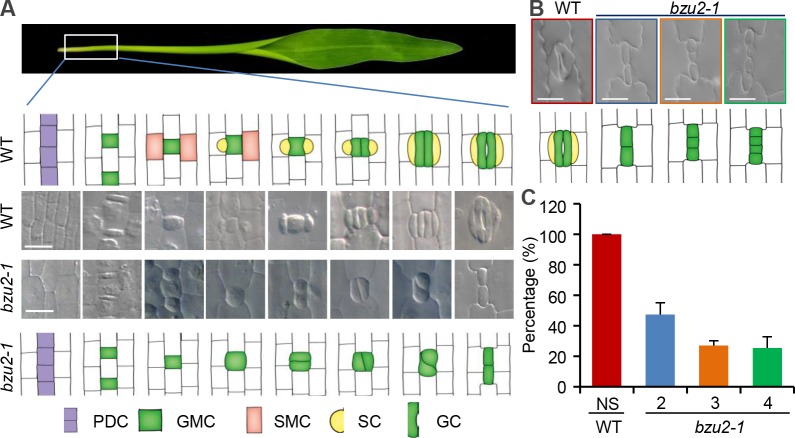
BZU2 is required for the formation of guard cells and fate determination of subsidiary mother cells.(A) Diagrams show the stomatal development file of the base of the second leaf, comparing wild-type and bzu2-1 mutants. In maize leaves, stomata are arranged linearly, being strongly zoned with the youngest at the base of the leaf (first panel). The cell proliferation zone of the files (purple region), where the stomata will form, is established first. Next, an asymmetric division of the protodermal cell establishes a GMC (green) and laterally induces SMC fate (orange). Subsequently, SMCs divide asymmetrically to form the SCs (yellow), prior to a final symmetric division of the GMCs to form the mature stomatal complex, comprising two GCs (green) and two SCs (yellow) (second and third panel). Compared to the wild-type, in bzu2-1 mutants, PDC can develop to GMCs at early stages of this process. However, SMCs do not undergo the asymmetric division to form the SCs, and the longitudinal symmetric division of GMCs is disturbed. Instead, they undergo transverse or diagonal longitudinal divisions that produce short columns of elongated cells lacking characteristic guard cell morphology (fourth and fifth panel). Scale bars, 25 μm. (B) Images of stomata illustrating the phenotypic range observed in bzu2-1 mutants in the first leaf. Wild-type plants have 4-celled stomatal complexes comprising two GCs and two SCs. bzu2-1 mutant plants never make SCs and, instead, produce two-celled defective stomata. These sometimes undergo one or two more divisions to form 3- and 4-celled defective stomata. Scale bars, 25 μm. (C) Percentage of stomatal complexes showing irregular divisions of the GMCs in bzu2-1 mutants. In the first leaves from 8-day-old wild-type and bzu2-1 mutants, three independent micrographs were examined, each value representing the mean (± SD), with error bars indicating SD, n = 6, **P<0.01, Student’s t test. In wild-type plants, all stomata are normal (NS, 100%). In comparison, no normal stomata (NS, 0%) were seen in bzu2-1. Out of 252 stomata surveyed in bzu2-1 mutants, 48% contained 2 cells, 27% contained 3 cells, and 25% contained 4 cells. Abbreviations: Normal stomata (NS), two-celled (2), three-celled (3) and four-celled (4).